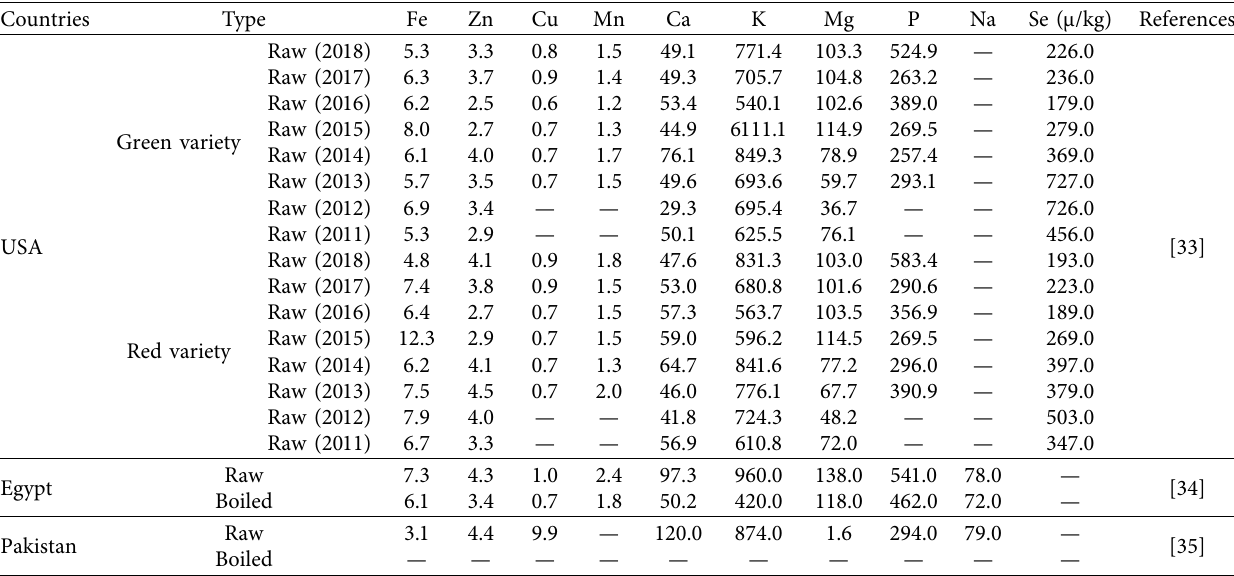
Table 3: Mineral lentil composition (unit: